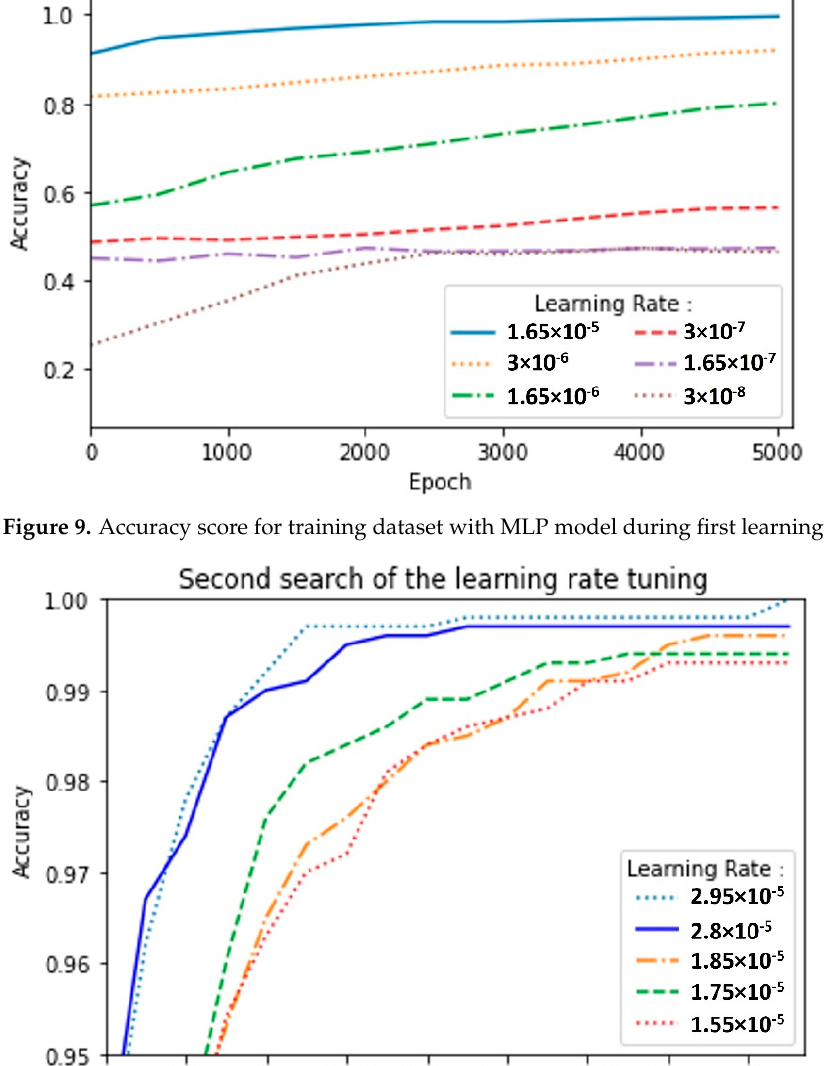
Figure 10. Accuracy score for training dataset with MLP model during second learning rate search.